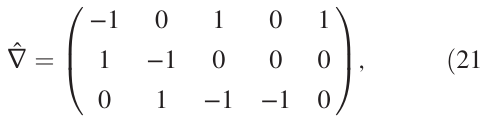
and the number of trees is thus T ¼ 8 .